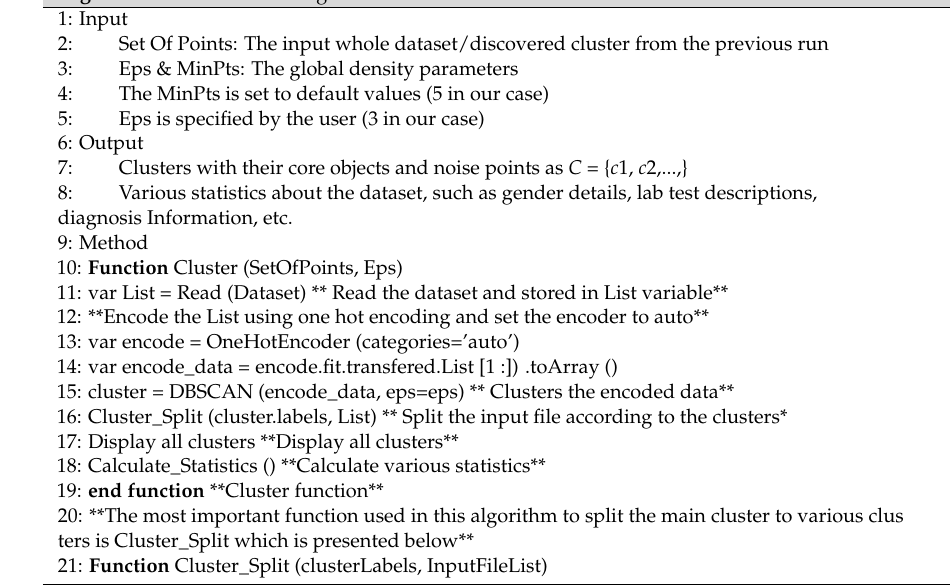
Algorithm 2 Machine learning